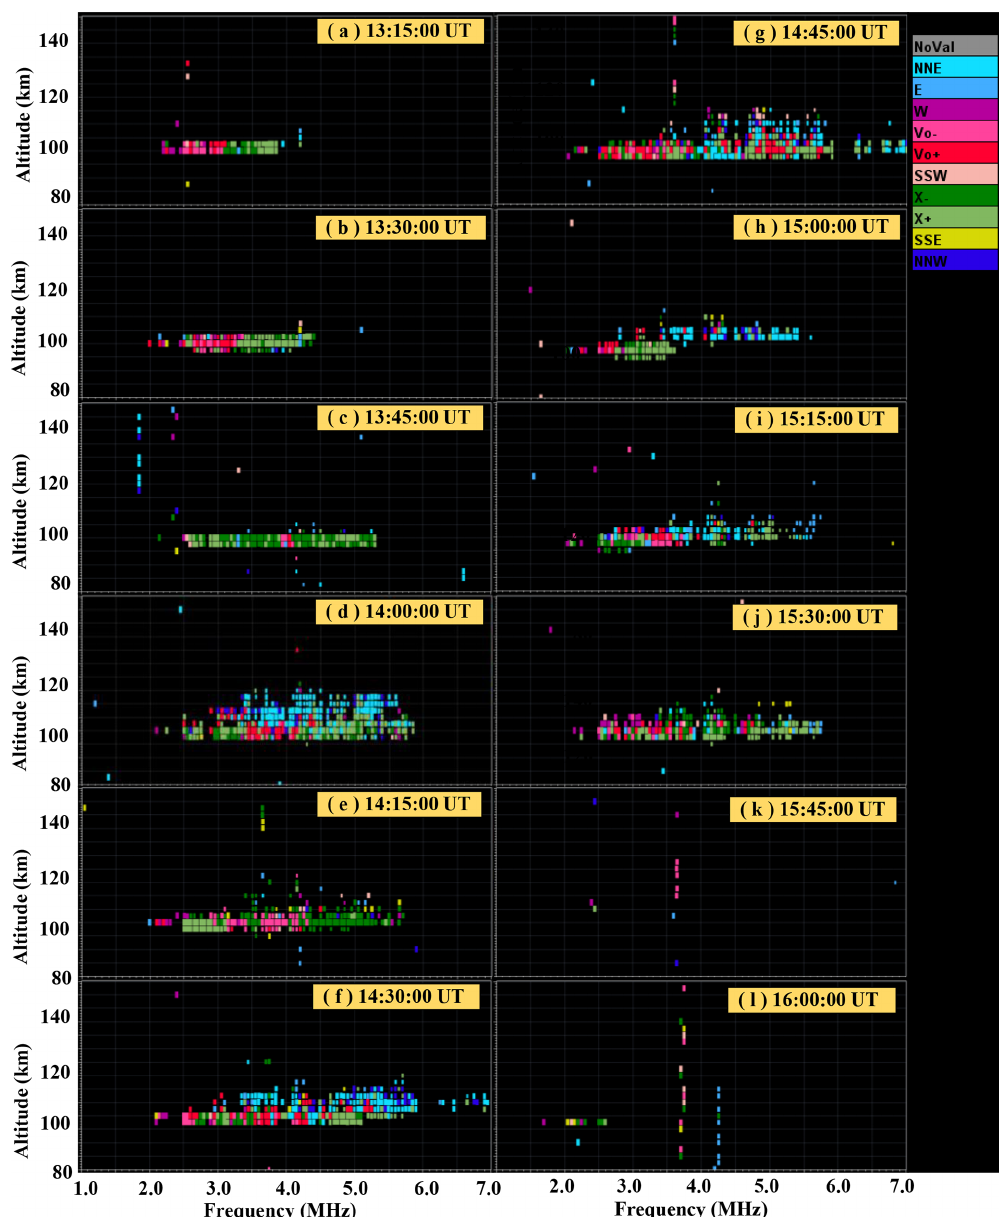
Figure 5. Extraordinary echoes by the Wuhan ionosonde in different modes. (a–c) From 13:15 to 13:45UT, the echoes gradually increase. Note that the powerful lightning period begins at 13:15UT as well, with the sodium density enhancement and the E S depletion occurring at about 13:20UT. (d–g) The most intense echo signals occur during 14:00 to 14:45UT, while the largest intensity of sodium enhancement begins at 14:20UT and the sodium density peaks at 14:40UT. The overturning of the electric field also occurs at 14:20UT. (h–j) From 15:00 to 15:30UT, the signals weaken gradually. (k–l) The echoes vanish after 15:45UT. Afterwards, no strong stroke is detected again within the discussed area. Meanwhile, the ionospheric echoes diminish after 15:45UT, and the overturning of the electric field also recovers at about